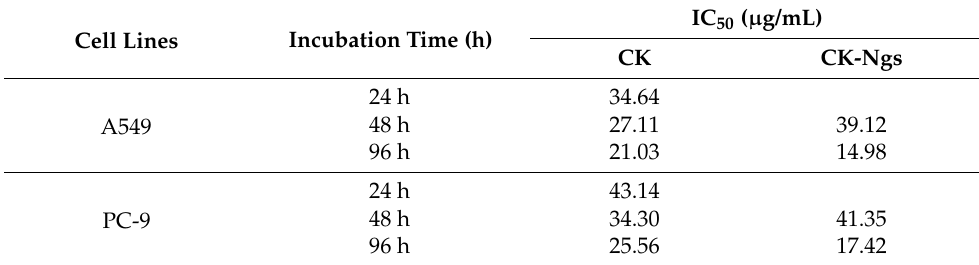
Figure 7. The analysis of IC 50 value of the two drugs on A549 and PC-9 cells. (* represents p < 0.05, ** represents p < 0.01). Table 3. The IC 50 of CK and CK-Ngs in A549 and PC-9.